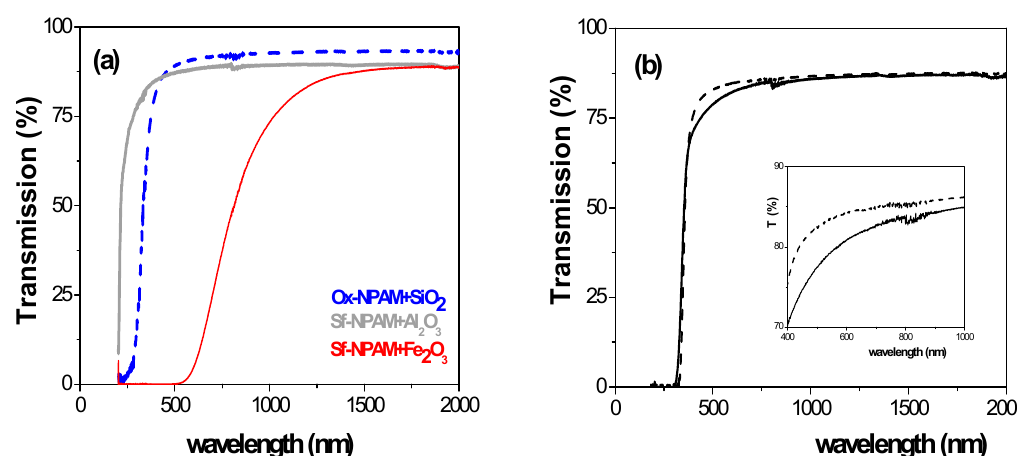
Figure 9. Light transmission spectra for ( a ) Sf-NPAM/Al 2 O 3 (solid gray line), Sf-NPAM+Fe 2 O 3 (solid red line), and Ox-NPAM/SiO2 (solid blue line) samples; ( b ) Sf-NPAM/TiO 2 (solid black line) and Ox-NPAM/TiO 2 (dashed black line) samples.